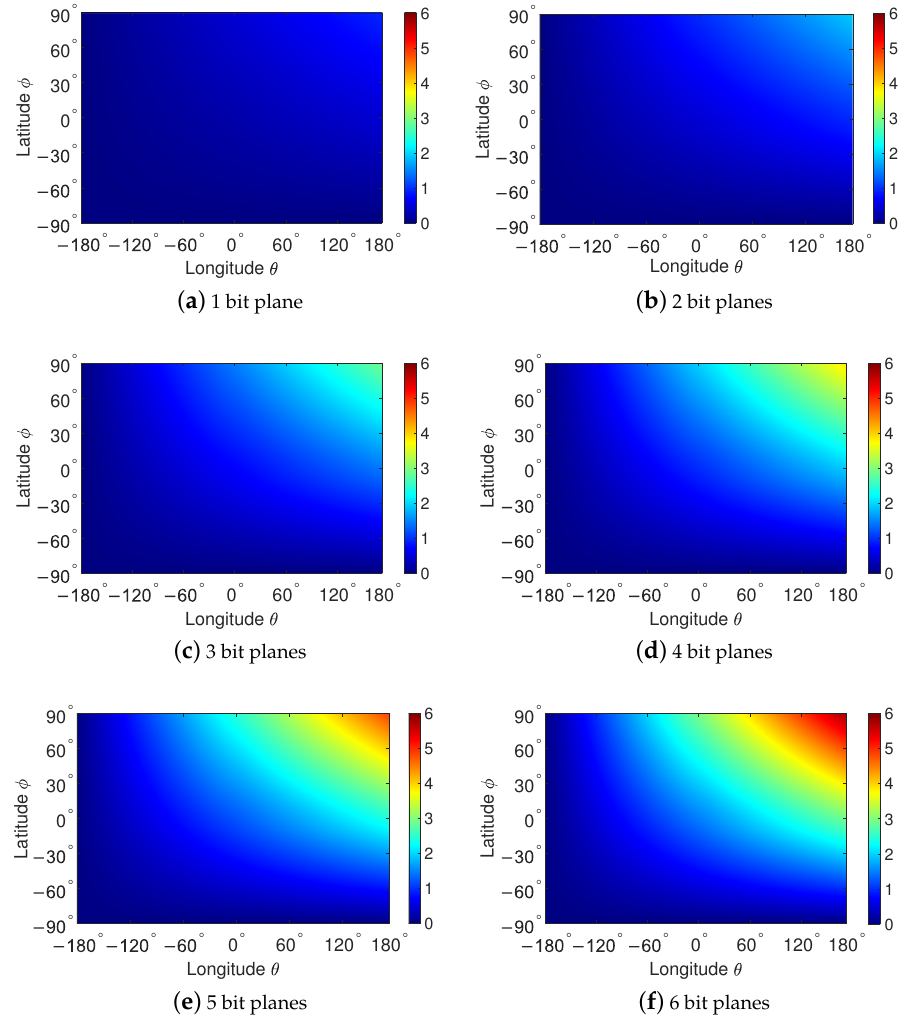
Figure 15. Capacity of viewing direction based data hiding in latitude and longitude. The total capacity in number of secret bits per frame that can be hidden in a color or luminance component per frame is obtained by multiplying (15), (17), and (18) with the resolution N × M of a given 360 ◦ video as